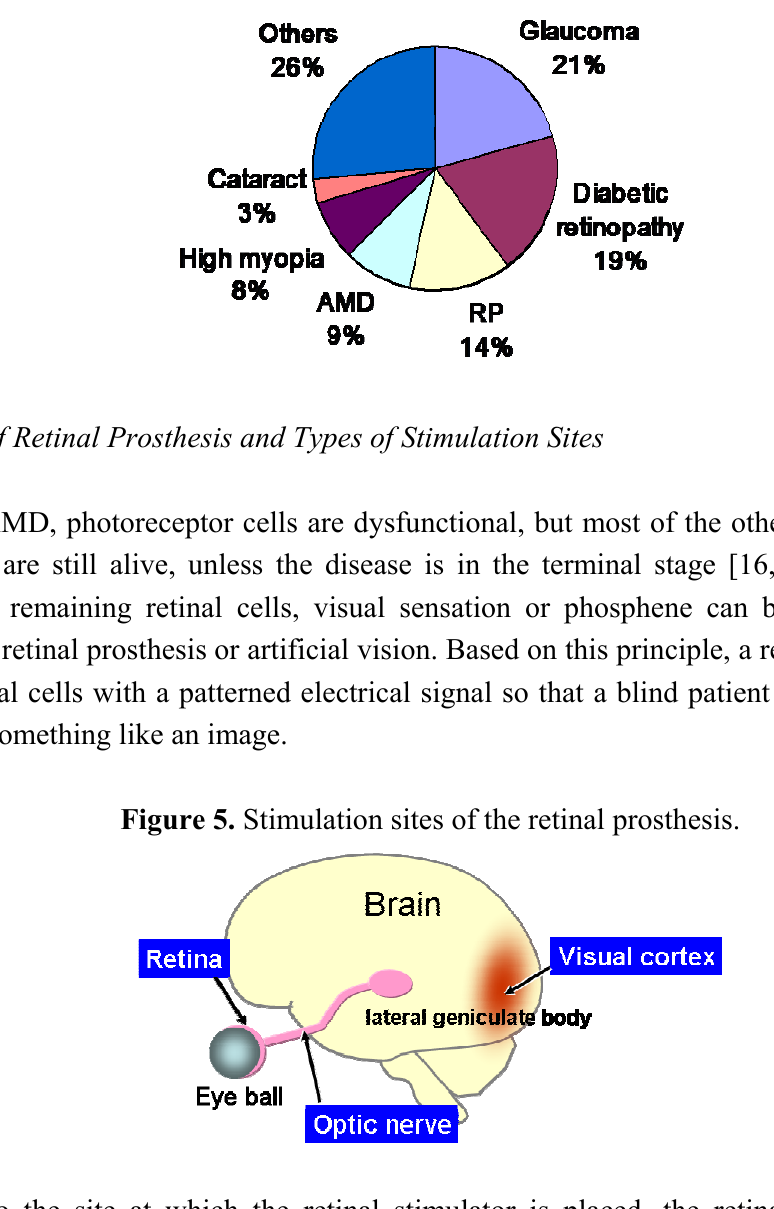
Figure 4. Ratio of causes of blindness in Japan (adapted from [15]). AMD: age-related macular degeneration. RP: retinitis pigmentosa.